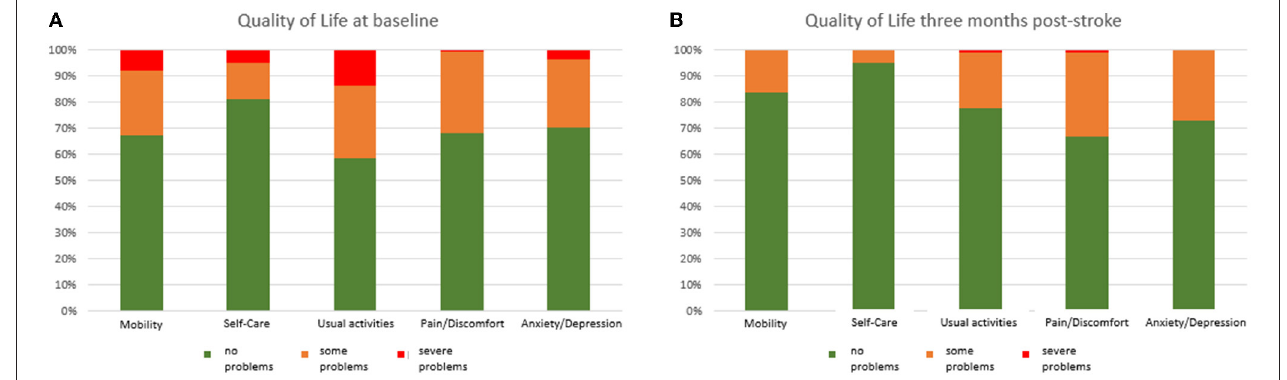
FIGURE 2 | Proportion of problems for each domain at baseline [BL, (A) ] and follow-up [FU, (B) ].